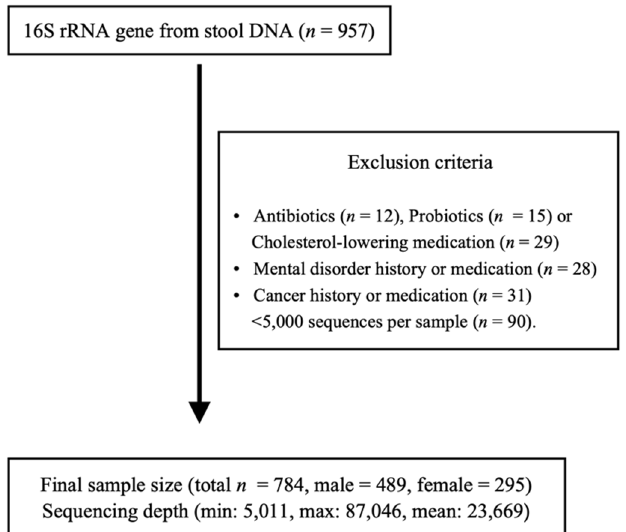
Figure 1. Enrollment of subjects. Inclusion criteria: 1463 Korean adults aged 23 to 78 years who agreed to participate in this study and provided stool samples at Kangbuk Samsung Hospital Healthcare Screening Center out of those who underwent annual or biennial examinations during the study period between June 2014 and September 2014. Some individuals met several exclusion criteria.